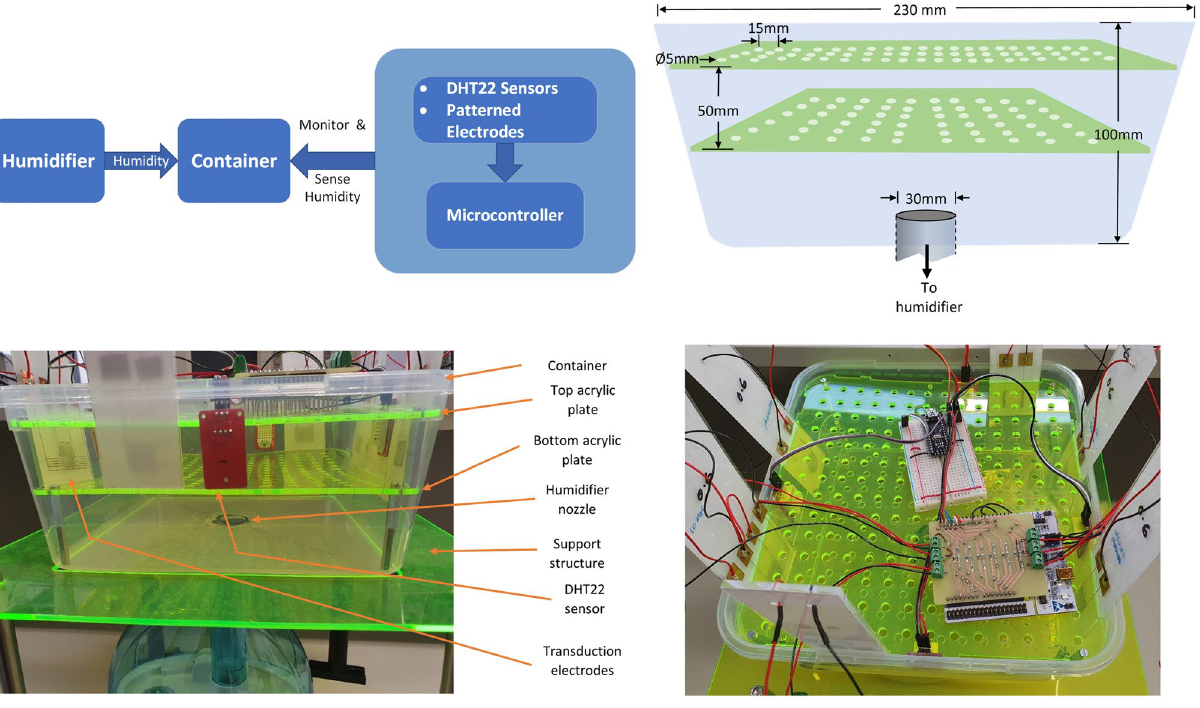
Figure 11. Layout of the experimental